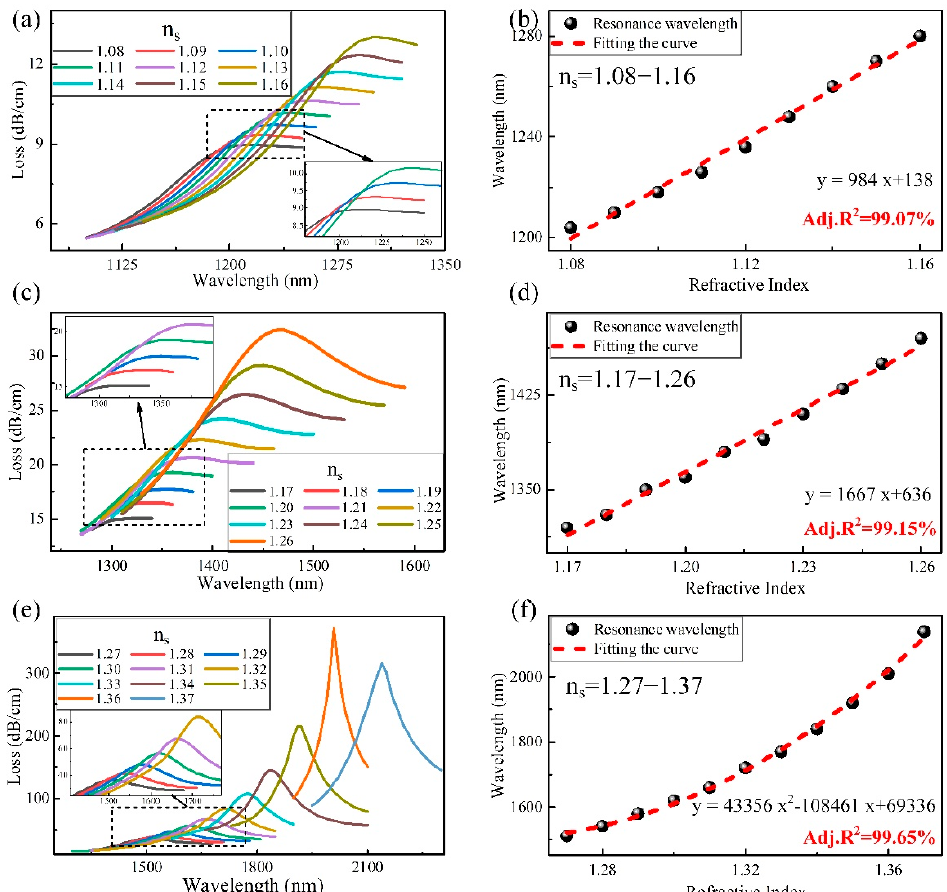
Figure 7. ( a ) Loss curves for analytes with refractive indices of 1.08 to 1.16; ( b ) resonance fitting curves for analytes with refractive indices from 1.08 to 1.16; ( c ) loss curves for analytes with refractive indices of 1.17 to 1.26; ( d ) resonance fitting curves for analytes with refractive indices from 1.17 to 1.26; ( e ) loss curves for analytes with refractive indices of 1.27 to 1.37; ( f ) resonance fitting curves for analytes with refractive indices from 1.27 to 1.37.